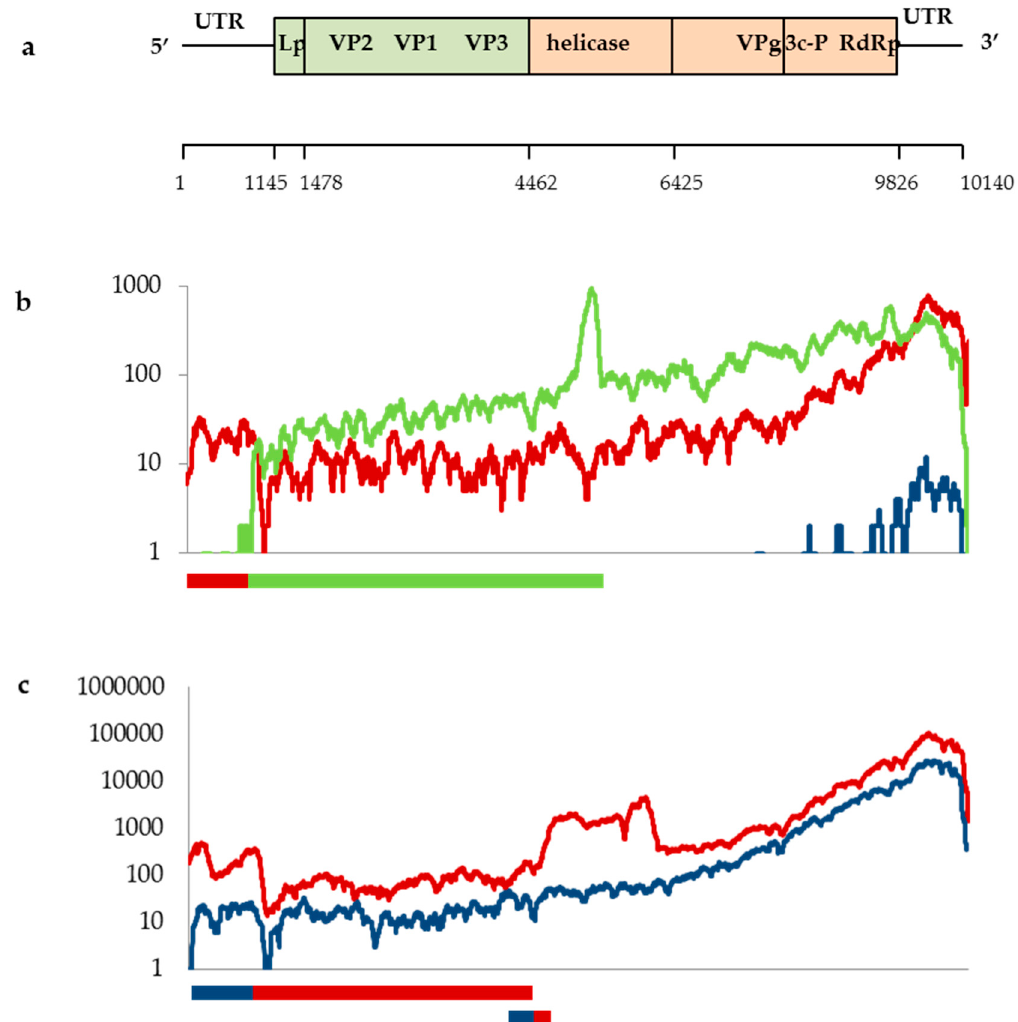
Figure 2. DWV genome coverage plots showing read depth of DWV-A (red), DWV-B (blue), and DWV-C (green), across the length of the genome, along with representations of VICUNA-assembled contigs showing recombination breakpoints; ( a ) genome organization with the structural region in green and the non-structural region in orange, showing nucleotide positions below (adapted from [33,34]); ( b ) small hive beetle sample A_tum_5; ( c ) yellowjacket wasp sample V_pen_8. Plots for all samples are shown in Figure S1, and nucleotide alignments showing the recombinant contigs for samples A_tum_5 and V_pens_8 are shown in Figure